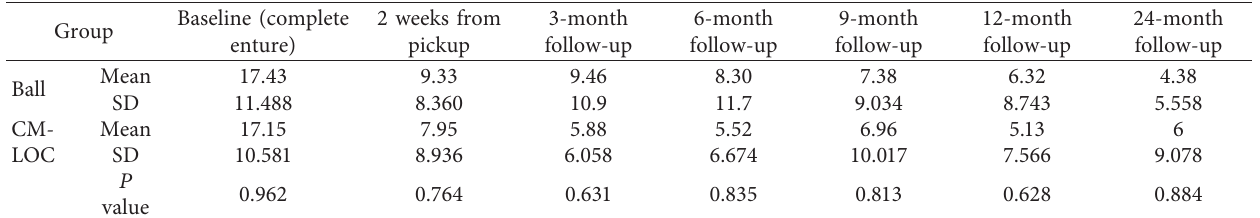
Table 4: Mean scores and standard deviation of masticatory ability at baseline; 2 weeks from loading; and 3-, 6-, 9-, 12-, and 24-month follow-up, for patients of the ball and CM-LOC attachment